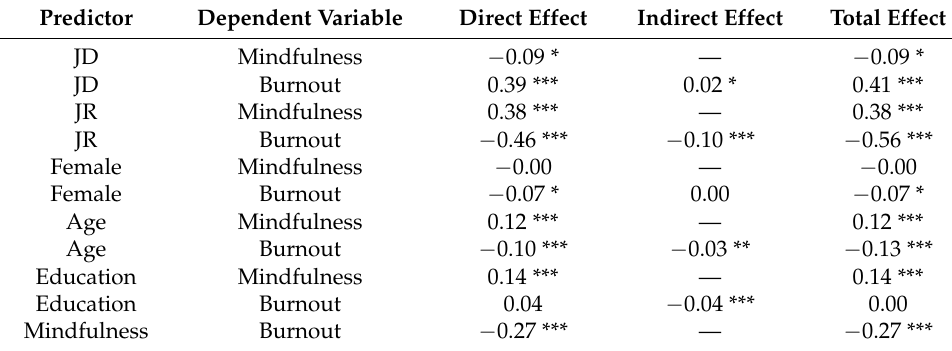
Table A1. Full Results of Mediation